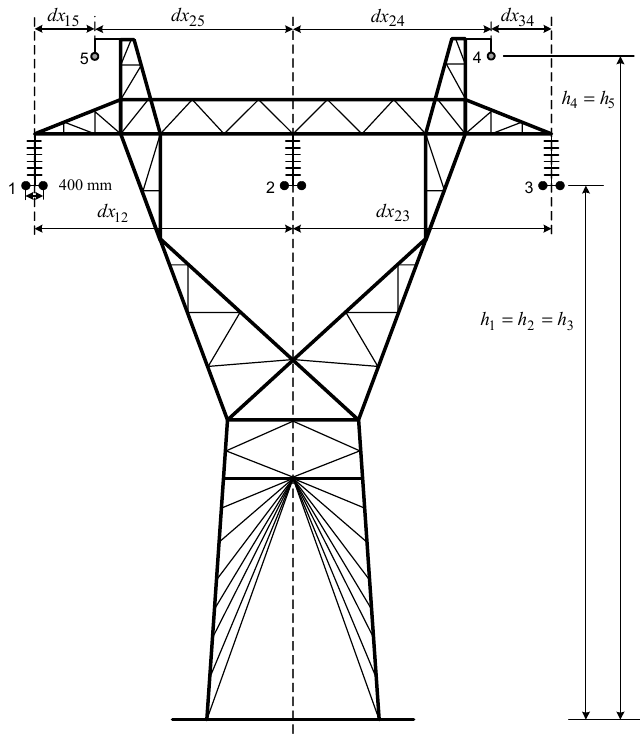
Figure A1. 400 kV power-line pole.